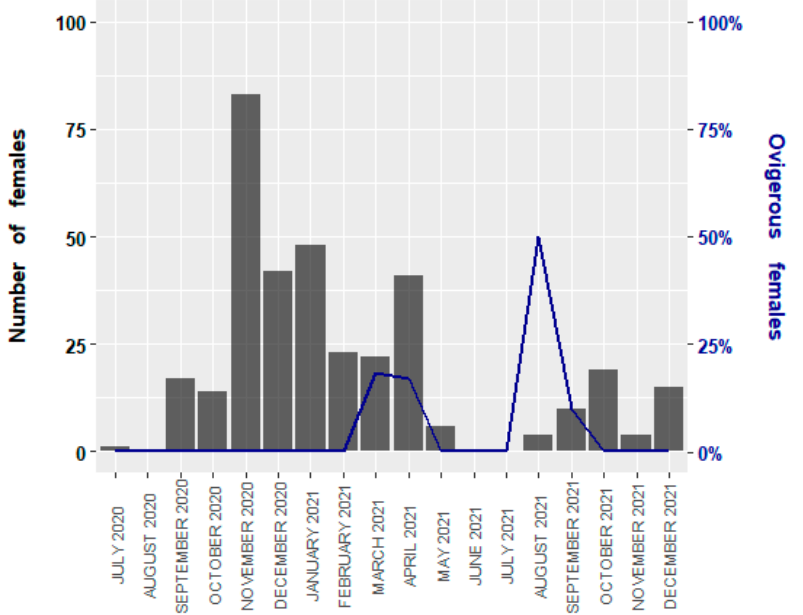
Figure 6. Percentage of ovigerous females (blue line) and the total number of captured females (grey bars) of Percnon gibbesi caught on the coast of Gran Canaria between July 2020 and December 2021.